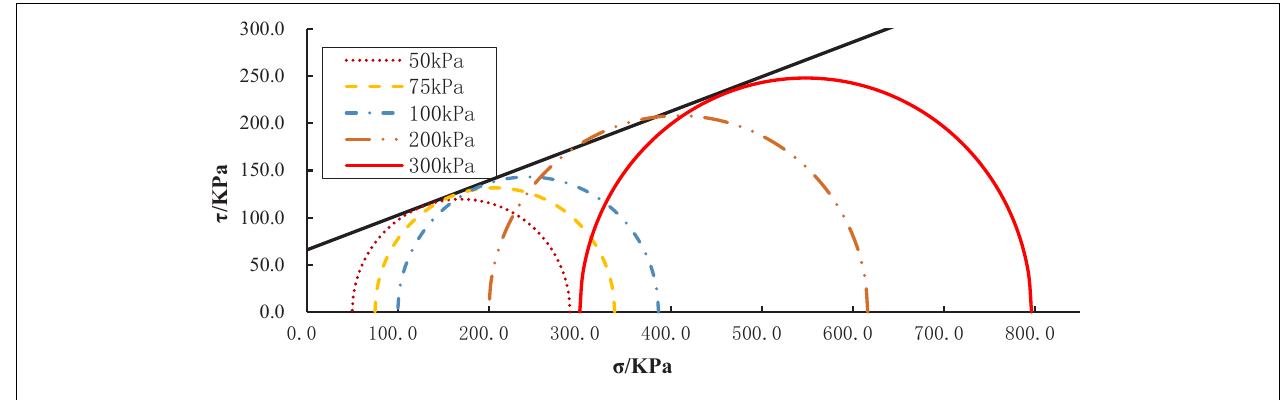
FIGURE 6 | Mohr Circles and shear envelope developed for the red clay samples tested at low confining stress range i.e., 50–300 kPa.